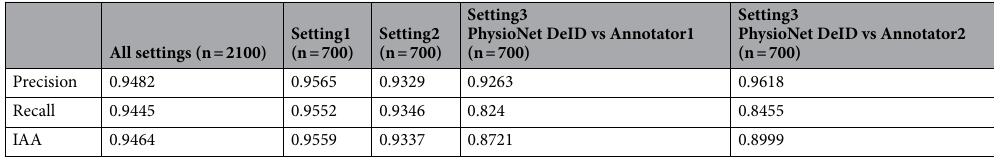
Table 3. IAA across individual settings.